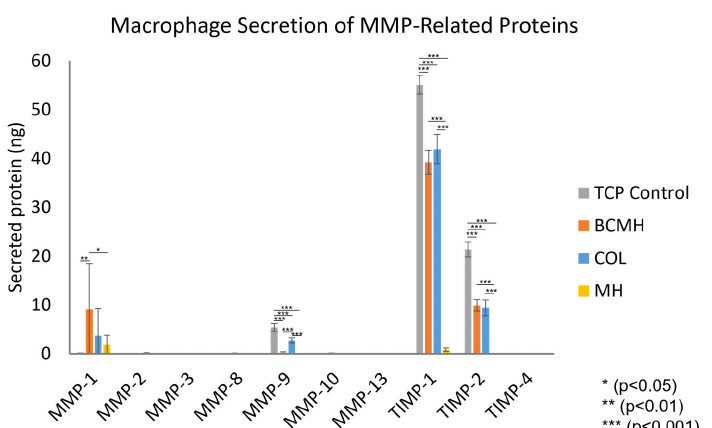
Figure 1. Amounts of MMPs secreted by human macrophages cultured 24 h with each test material ( n = 9). Proteins detected in the cell culture samples were MMP ‐ 1, MMP ‐ 9, TIMP ‐ 1, and